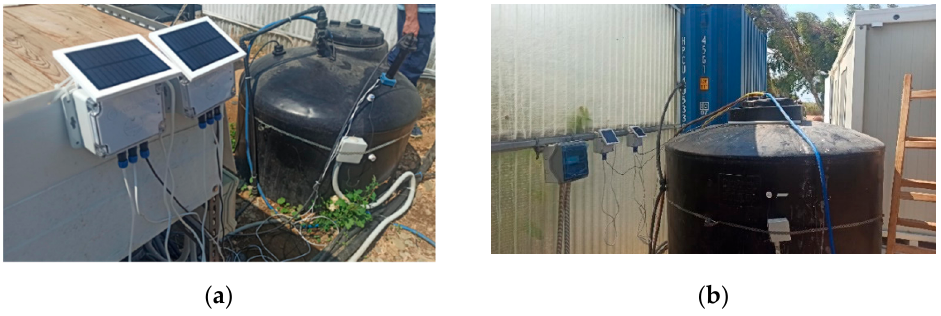
Figure 16. Monitoring of water quality: ( a ) seawater tank; ( b ) irrigation tank.